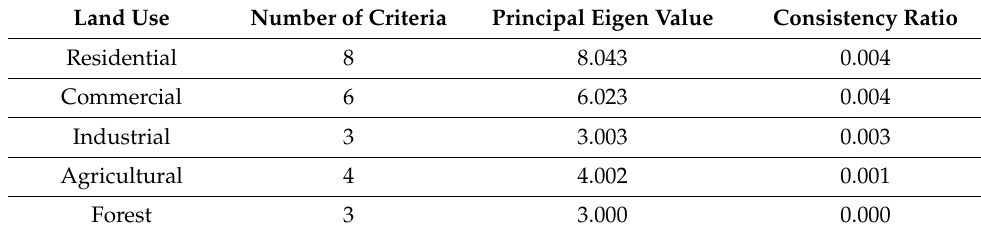
Table A1. Consistency Ratio of the pairwise comparisons for the collective preferences.